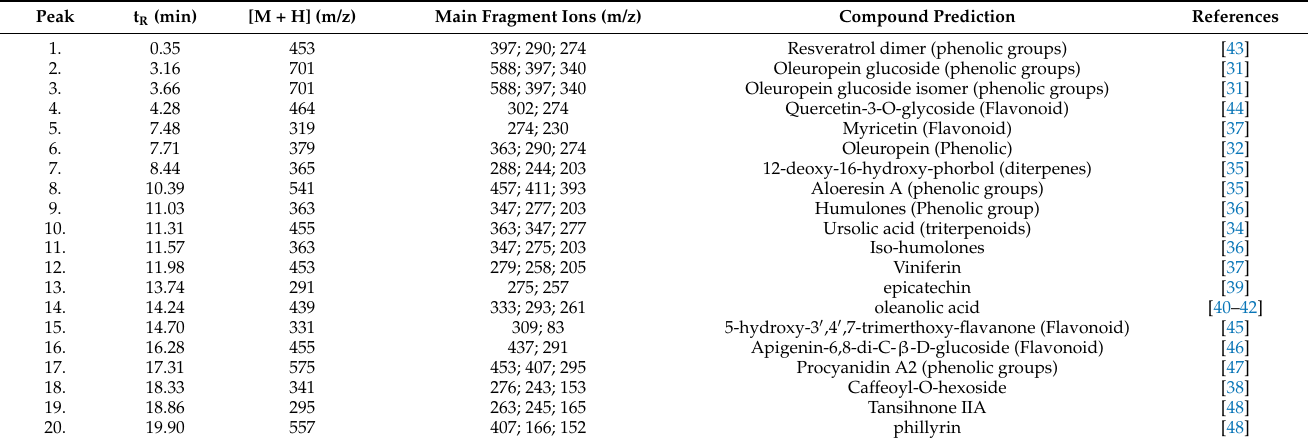
Table 4. Qualitative and quantitative phytochemical analysis of fraction B from methanol extract of Lantana camara